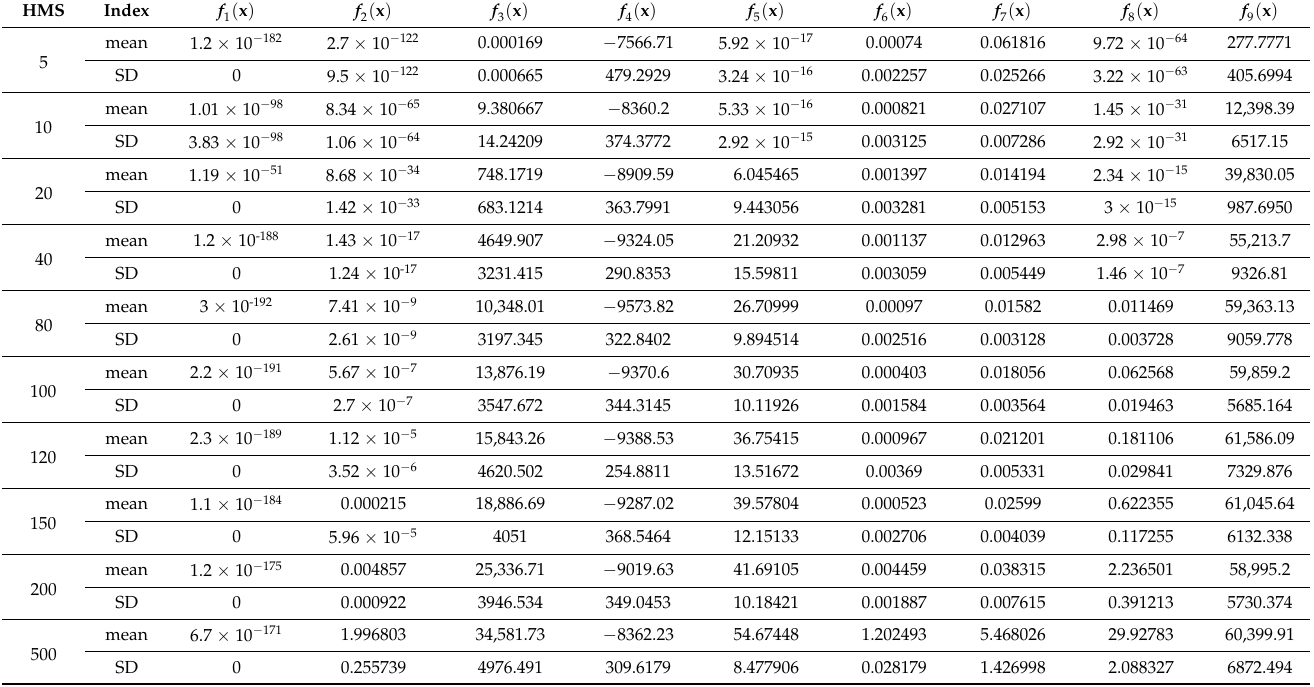
Table 4. Effects of HMS for nine